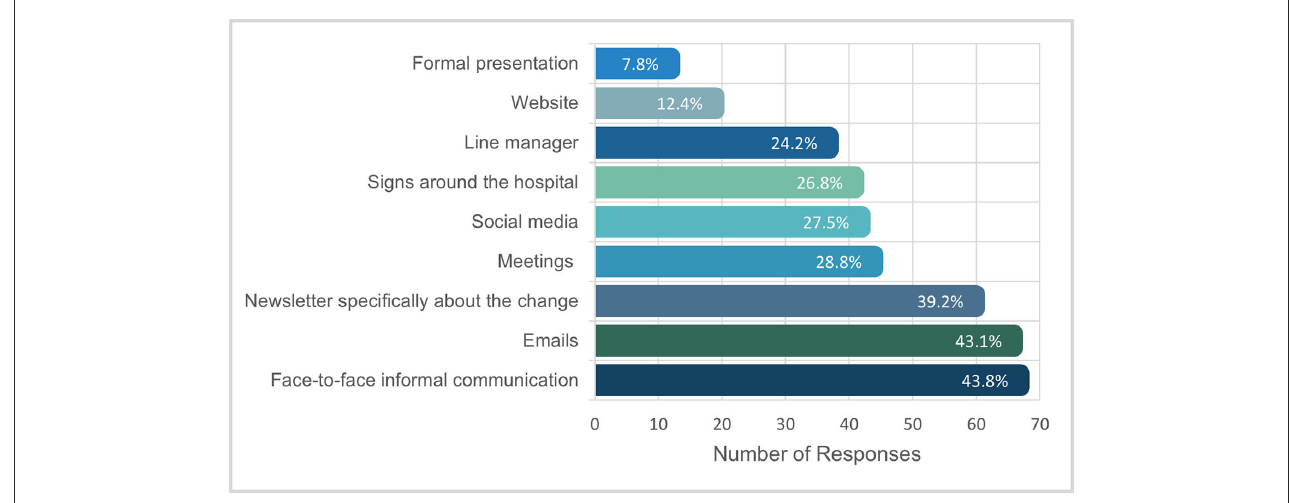
FIGURE3 Usefulness of channels of change